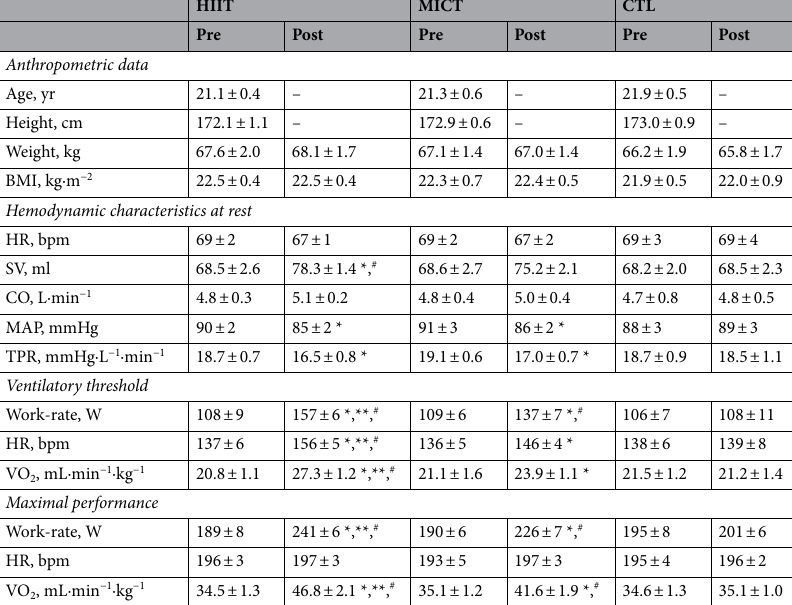
Table 1. The effects of interval and continuous exercise regimens on cardiopulmonary fitness in normoxia. Values were mean ± SEM. Data of hemodynamic characteristics at rest were acquired from the subjects who rested for 5 min on a bicycle. HIIT, high-intensity interval training group; MICT, moderate-intensity continuous training group; CTL, control group; Pre, pre-intervention; Post, post-intervention; BMI, body mass index; HR, heart rate; SV, stroke volume; CO, cardiac output; MAP, mean arterial pressure; TPR, total peripheral pressure; VO 2 , oxygen consumption. * P < 0.05, Pre vs . Post; ** P < 0.05, HIIT vs. MICT; # p < 0.05, HIIT or MICT vs